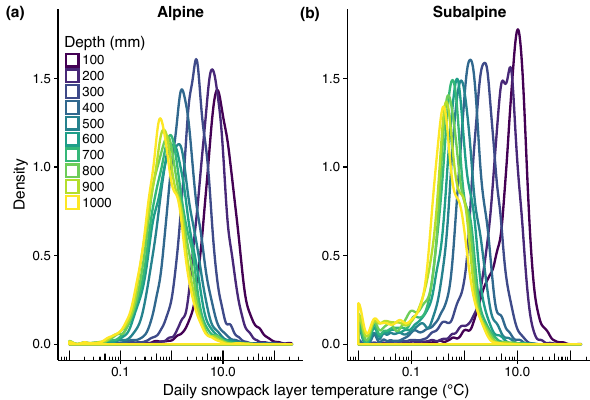
Figure 10. Annual melt onset as predicted by peak cold content tim- ing and spring precipitation in the alpine (a) and subalpine (b) . The background gradient in each plot displays the predicted melt onset date as calculated by a multiple linear regression, while the shad- ing within each point represents the actual melt onset simulated in a given water year at its peak cold content date and spring precipi- tation value.